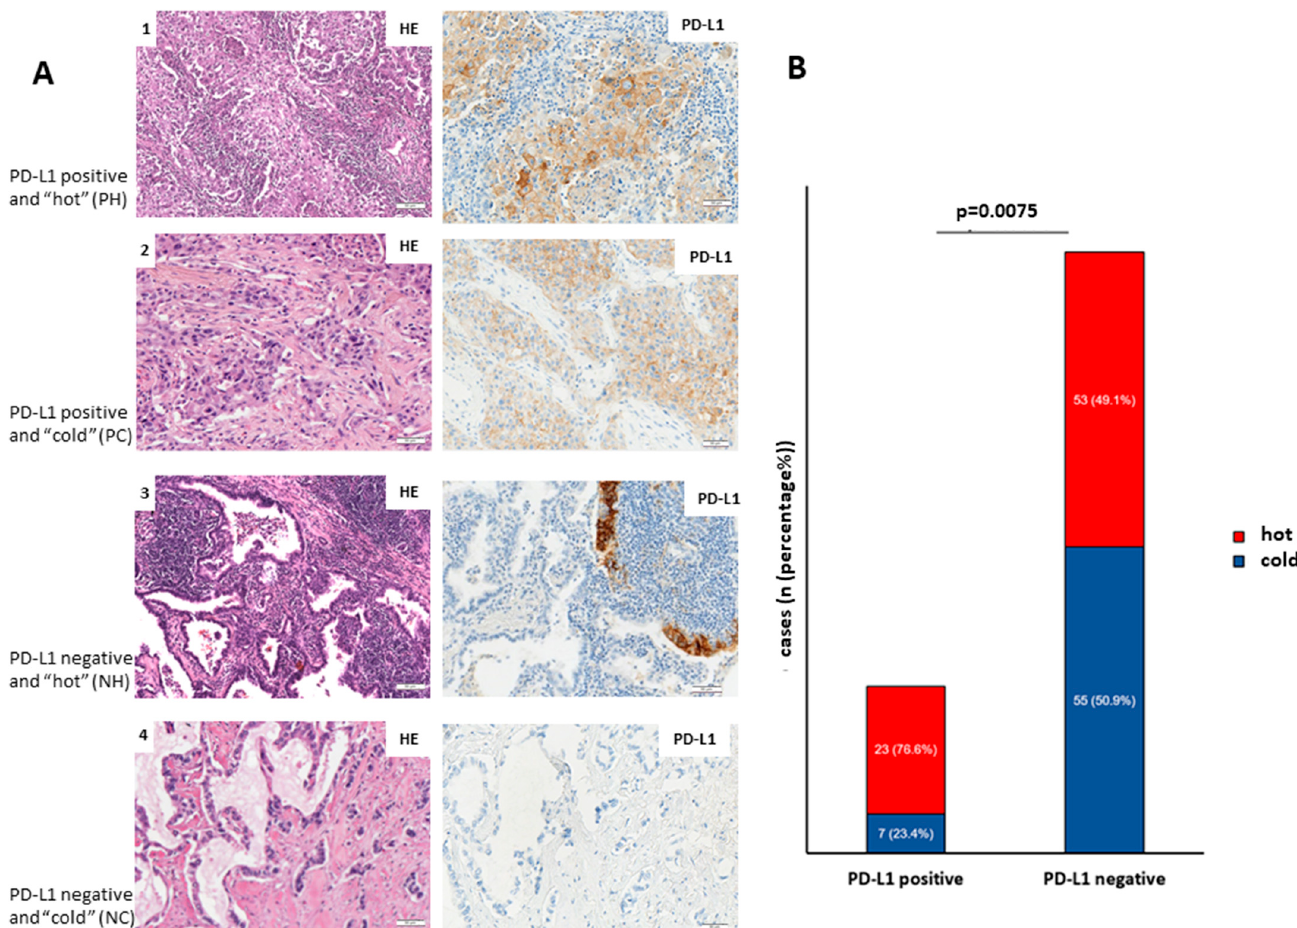
Figure 2. Characterization of the cohort. ( A ) PD-L1 expression in lung adenocarcinoma correlates with total immune infiltration. Representative images of PH (lane 1), PC (lane 2), NH (lane 3), and NC (lane 4) LUADs ( B ) Bar graph showing the distribution of the cohort in subgroups PH, PC, NH, and NC. Scale bar: 50 μ m.